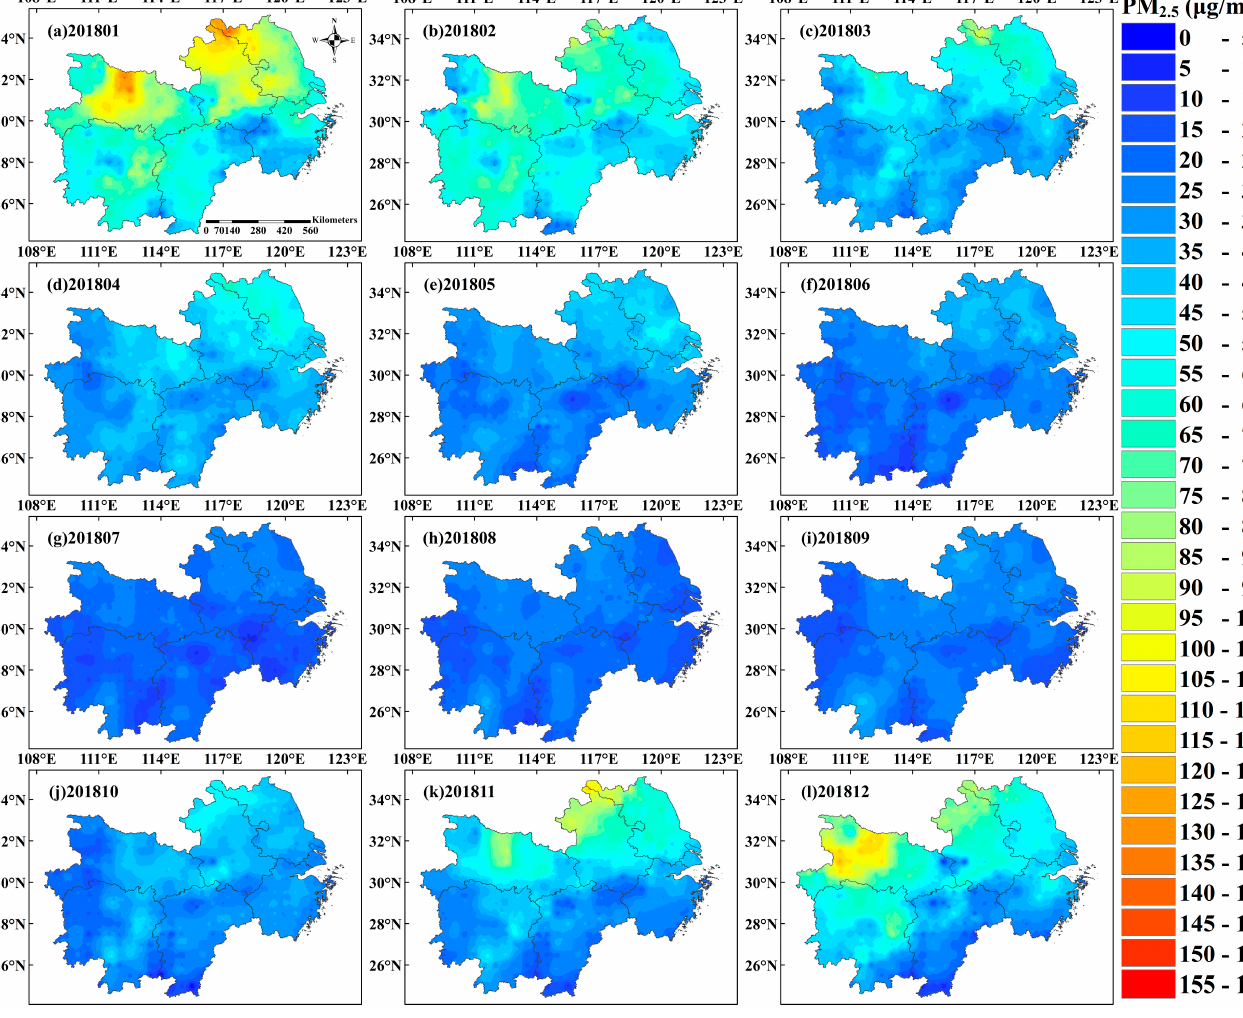
Figure 11. The spatial distribution of PM 2.5 concentrations from January to December 2018 ( a – l ) is shown by different color bands indicating the distribution of PM 2.5 concentrations.